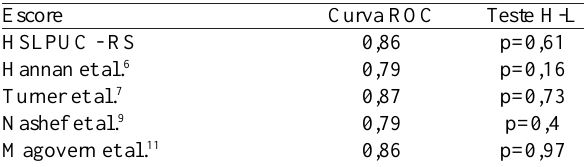
Tabela 6. Acurácia do